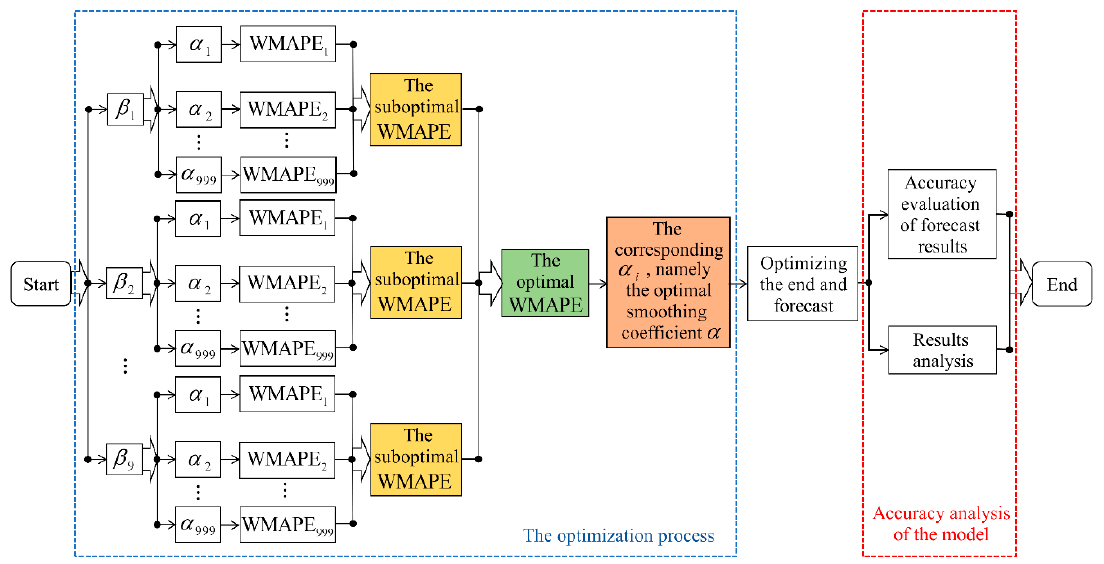
Figure 1. Flow chart of the optimization process of the thick near thin far (TNTF) principle.